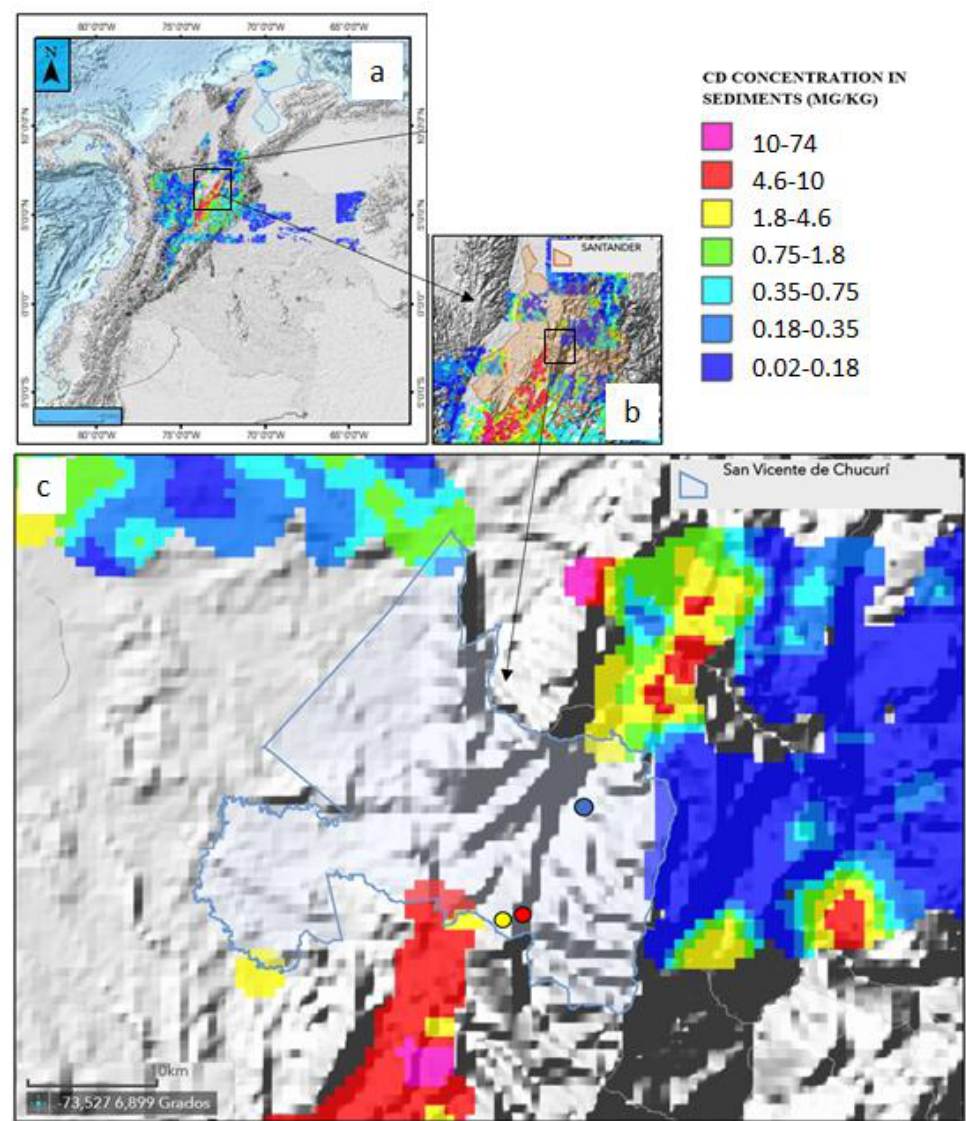
Figure 5. Map of cadmium content in sediments (mg/kg) in Colombia [39]. ( a ) Geochemical map of Cd for Colombia. ( b ) Geochemical map of Cd for Santander. ( c ) Geochemical map of Cd for San Vicente de Chucurí, Farm 1 (red dot), Farm 2 (yellow dot) and Farm 3 (blue dot) are indicated.